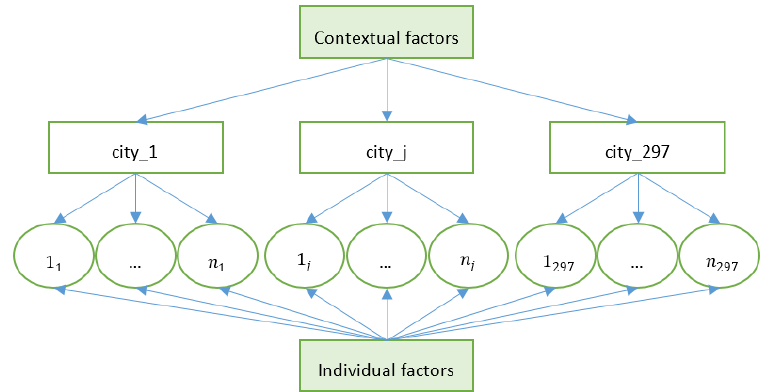
Figure 3. Unit diagram if a two ‐ level nested structure: older migrants in cities.